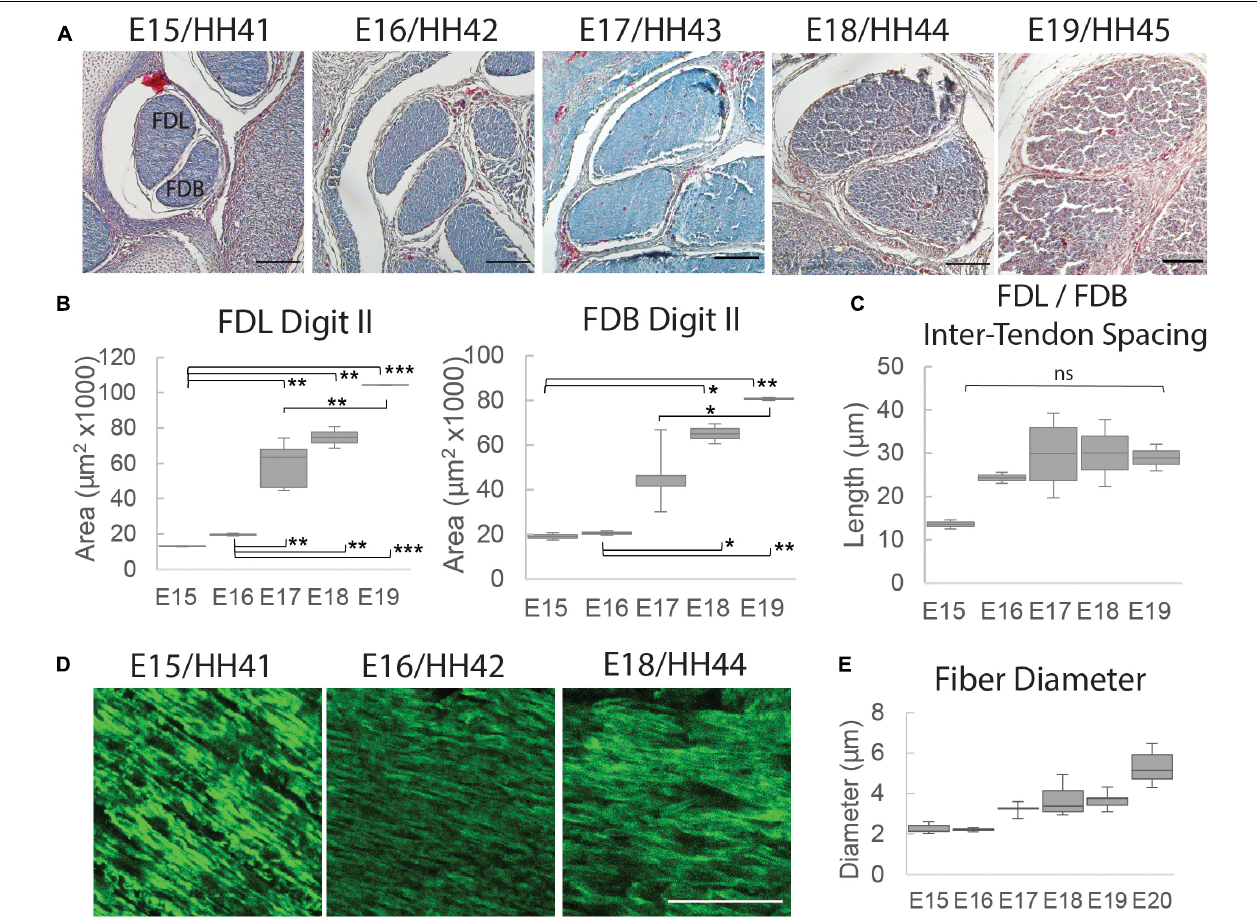
FIGURE 4 | Structural analysis of tendons between E15 (HH41) and E19 (HH45). (A) Cross-sectional profile of the flexor digitorum longus (FDL) and brevis (FDB) digit II tendons stained with Masson Trichrome in the tarsometatarsal region of the developing chick hindlimb over embryonic days, as indicated. Scale bar 100 µ m. (B) Box plots of cross-sectional area of the FDL and FDB digit II tendon over developmental time (plot whiskers indicate min and max data values). (C) Box plot of spacing measurements between the FDL and FDB digit II tendons over developmental time (measurements taken through a 700 – 1,330 µ m portion of the medial tarsometatarsal region, see Supplementary Figure 1 ). (D) Images of longitudinal tendon fibers in the tarsometatarsal region stained with collagen binding protein over developmental time. Scale bar 50 µ m. (E) Box plot of tendon fiber diameter measurements over time. Statistical analysis was carried by univariate ANOVA followed by Tukey post hoc tests. For (B,C) n = 2 per day except E17 (HH43) n = 5; For (E) n = 1 (multiple sections from 1 specimen/stage measured). * p ≤ 0.05, ** p ≤ 0.01, and *** p ≤